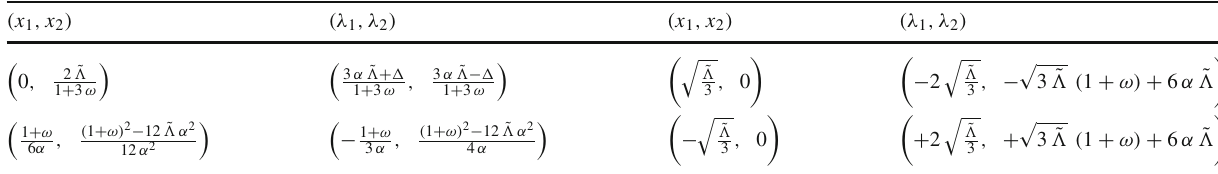
Table 3 Fixed points for variable viscosity coefficient, ˜ ξ = α x